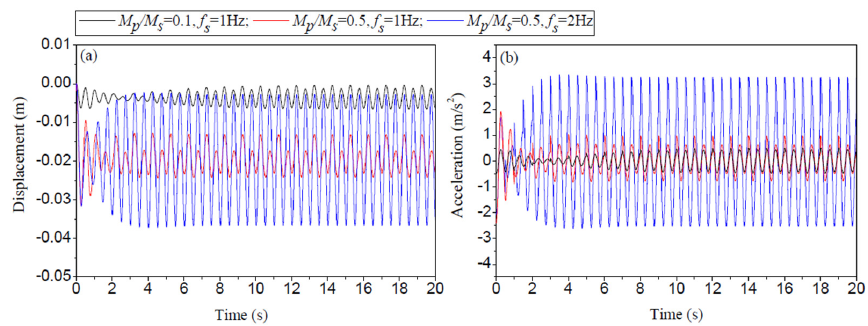
Figure 5. Effect of step frequency and crowd size on dynamic responses: ( a ) the larger mass ratio Mp/Ms = 0.5 induces the slightly larger vibrational displacement under the uniform non-resonant excitation rate f s = 1 Hz; however the resonant excitation rate f s = 2 Hz induces the noteworthy larger vibrational displacement amplitude under the same mass ratio M p / M s = 0.5; ( b ) the larger mass ratio M p / M s = 0.5 induces the slightly larger vibrational acceleration under the uniform non-resonant excitation rate f s = 1 Hz; but the resonant excitation rate f s = 2 Hz induces the remarkable larger vibrational acceleration amplitude under the same mass ratio M p / M s = 0.5.